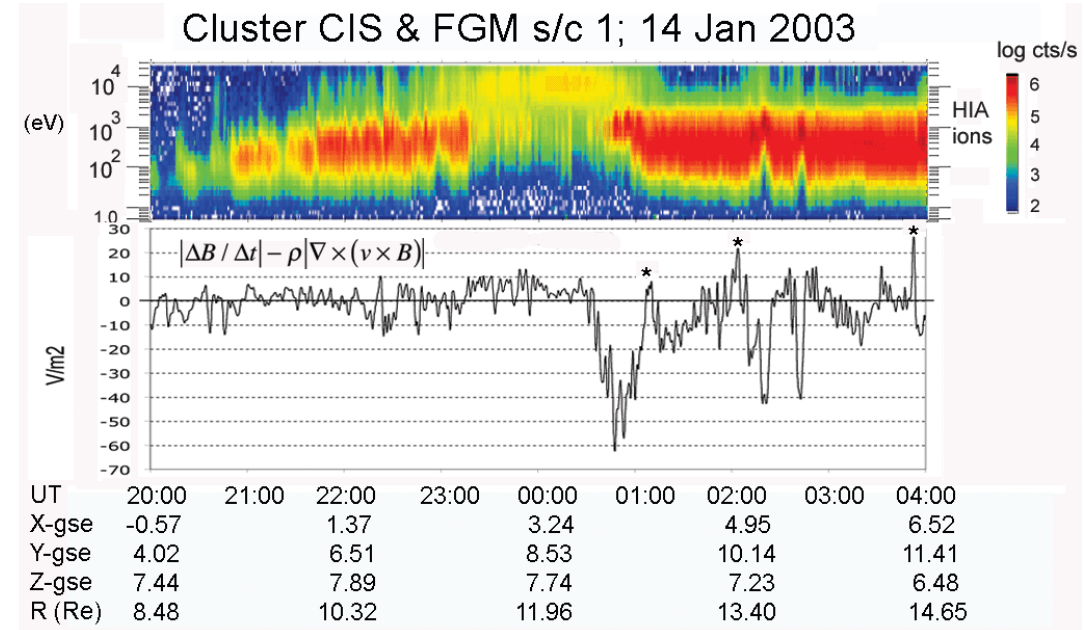
Fig. 9. Graph illustrating | 1B/1t |− ρ |∇× ( − v × B ) | (Eq. 6) versus time for the 14 January 2003 Cluster traversal. Negative values near the magnetopause ( ≈ 00:30–01:00 UT), i.e. d8/dt< 0 (diamagnetic effects), imply significant departure from ideal MHD and strong plasma forcing. d8/dt> 0 (magnetic induction) occurs during ≈ 23:00–00:30 UT. The magnetopause is traversed at ≈ 01:00 UT.